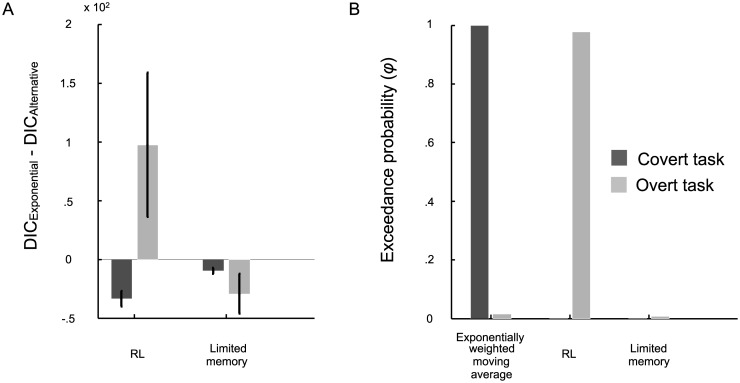
Model comparison results for the covert- (dark gray) and overt-criterion (light gray) tasks in Expt. 2.A) The bar graph depicts the relative DIC scores (i.e., DIC difference between the exponentially weight moving-average model and the alternatives) averaged across observers ±SE. Larger values indicate a better fit. B) To summarize the results from the group level analysis we computed exceedance probabilities for each model in each task. A model’s exceedance probability tells us how much more likely that model is compared to the alternatives, given the group data.